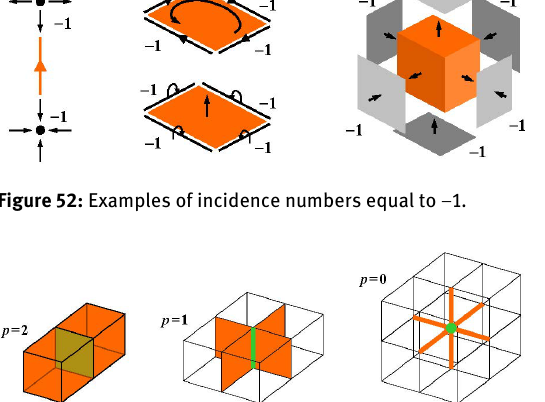
Figure 54: The incidence matrices in a plane cell complex (the sym- bol “ ¯ ” over the labels of the p -cells means that the p -cells are en- dowed with inner